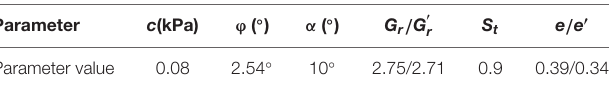
TABLE 2 | Debris flow calculation